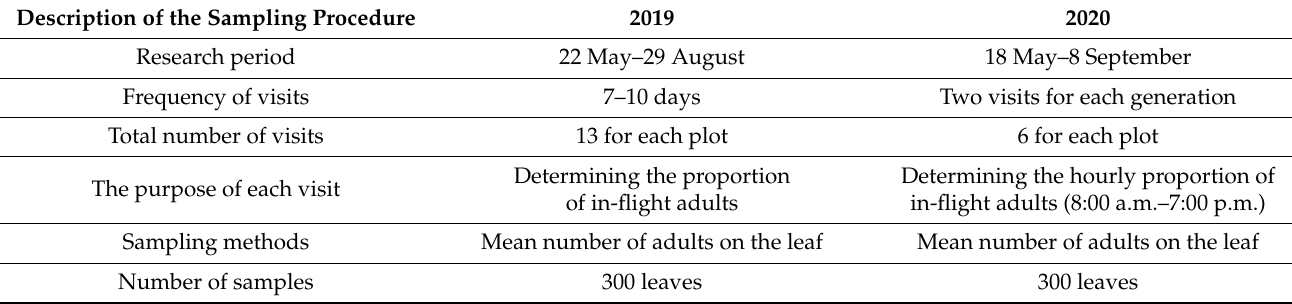
Table 2. Information on sampling procedures and research period from 2019 to